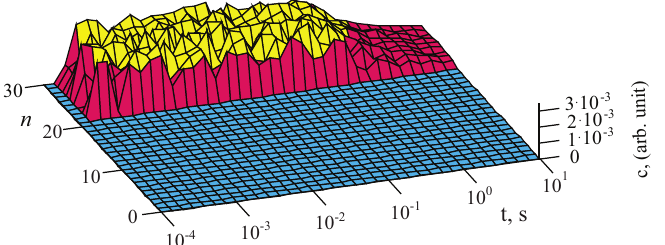
Figure 3. Dependences of the number of the charges at the ends of non-point dipoles on the changes of the length of the chains for the same parameters that are in Figure 2 but at the minimal number of charges c n = 1. The excitation field was switched off at the instant of time t ≥ 1 × 10 − 3 s